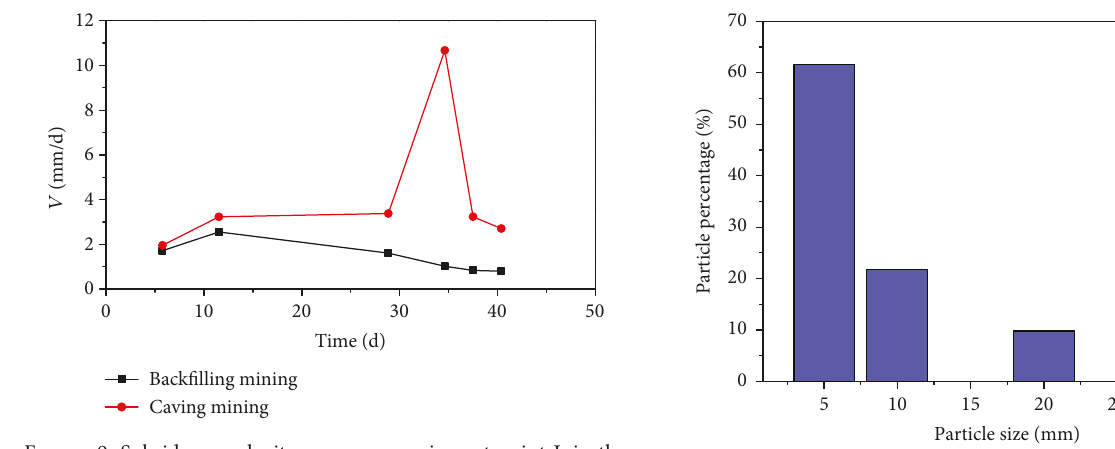
Figure 11: Distribution of particle size.